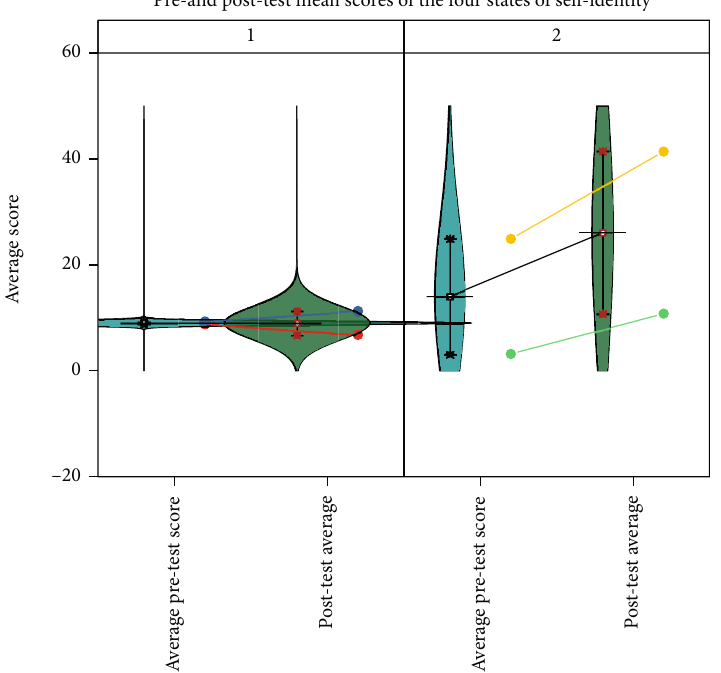
Figure 8: Mean scores of pre- and posttests of the four states of